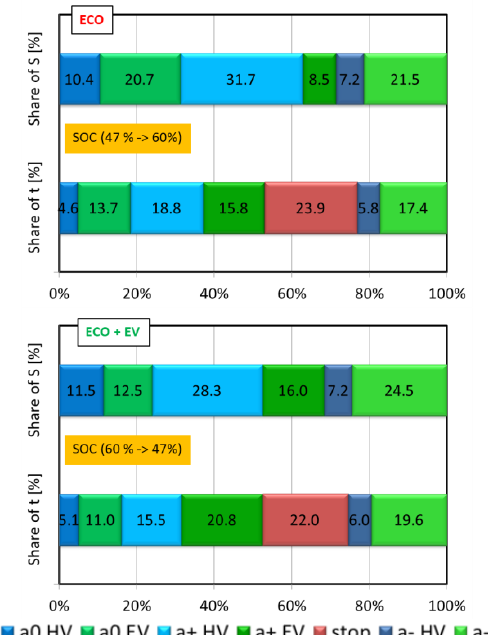
Fig. 5. The percentage share of individual driving modes in relation to time and distance traveled during the test